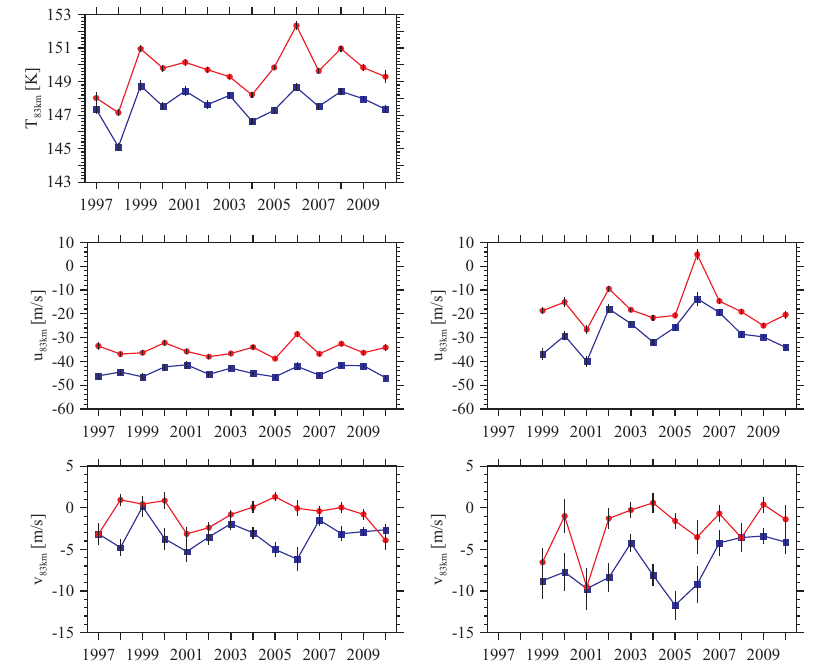
Fig. 7. Seasonal mean temperature (top), zonal (middle) and meridional (bottom) wind at 83km altitude above ALOMAR as calculated by the LIMA-model (left) and measured by the ALOMAR MF-radar (right). Data are based on hourly mean values. Only hours with ALOMAR RMR-lidar measurements are taken into account (long-term data set). Data are separated for confirmed absence (red circles) and presence ( β max > 4, blue squares) of NLC. Vertical bars are error of the means.